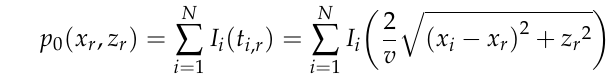
Figure 3. Simulation of LUS B-scan imaging. ( a ) The cross-sectional view of the target object. It is a line along y -axis but a uniform box in x-z plane. ( b ) The simulated B-scan image of the object in ( a ).